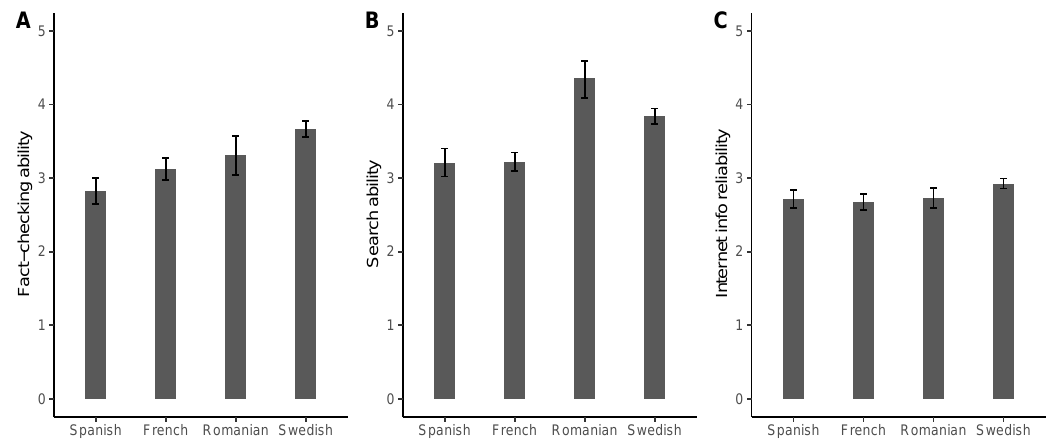
Figure 6. Mean ratings ( y -axis) with standard error of mean for ( A ) fact-checking ability, ( B ) search ability, ( C ) internet info reliability for each language on the x